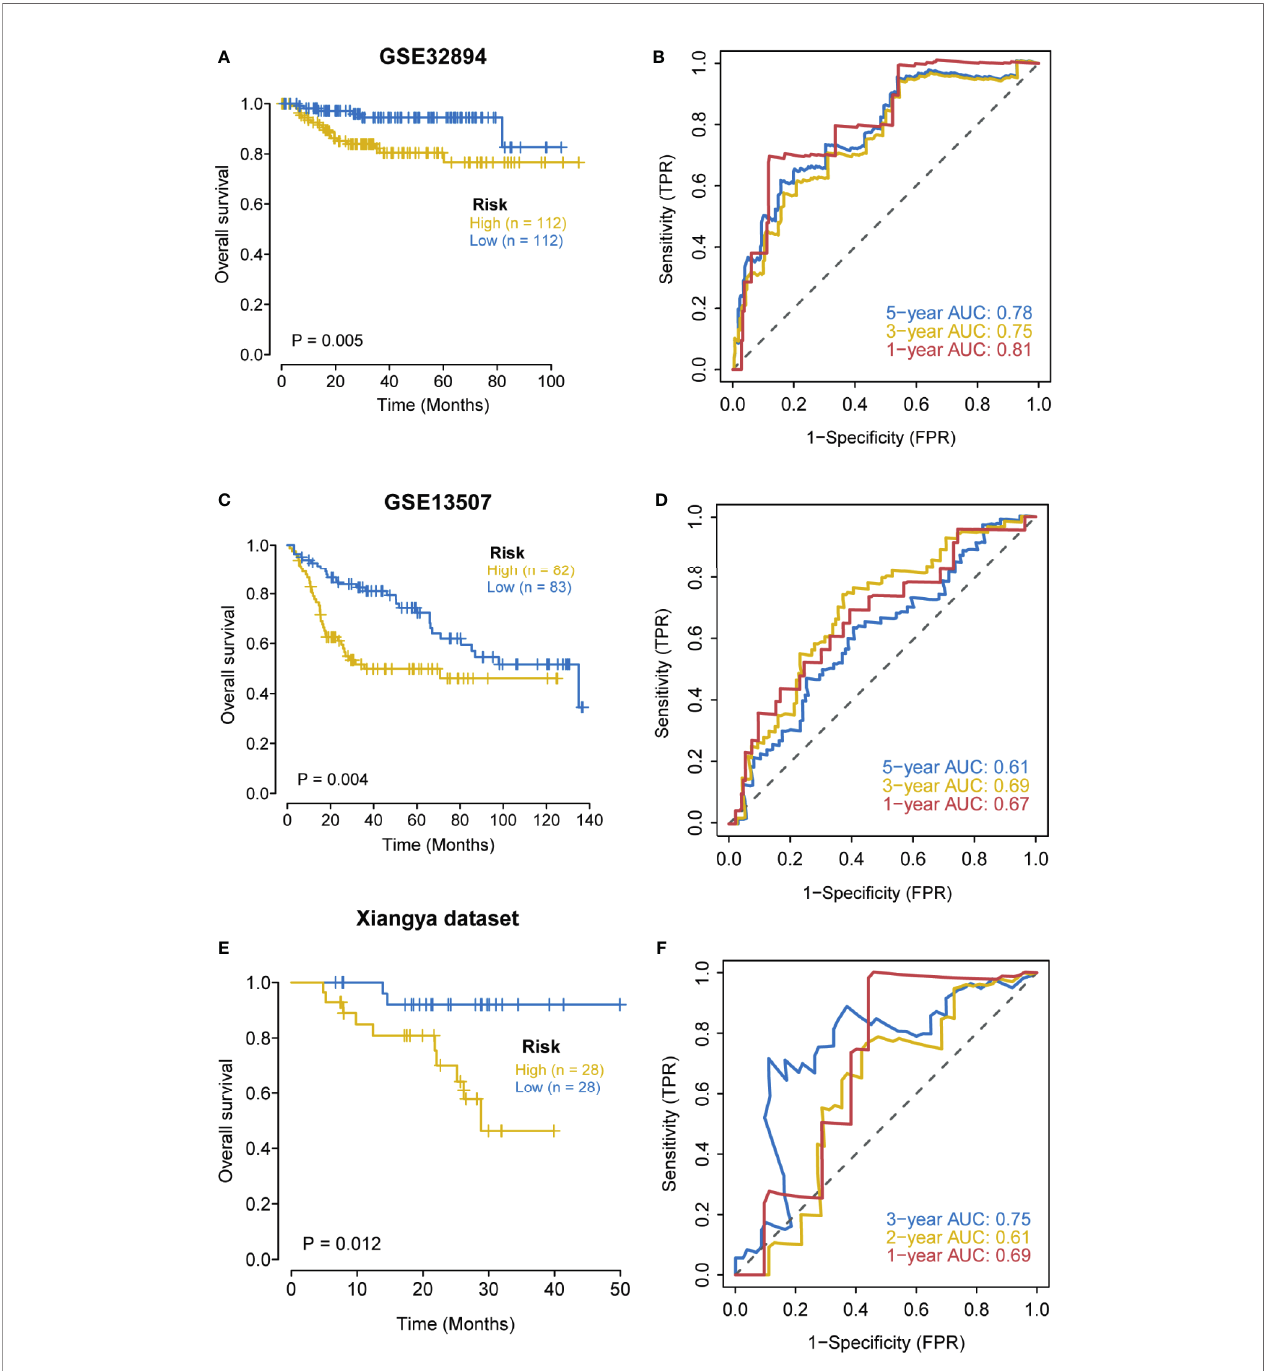
FIGURE 3 | External validation of the hypoxia risk score. (A, B) Validation of the hypoxia risk score in GSE32894. (C, D) Validation of the hypoxia risk score in GSE13507. (E, F) Validation of the hypoxia risk score in Xiangya